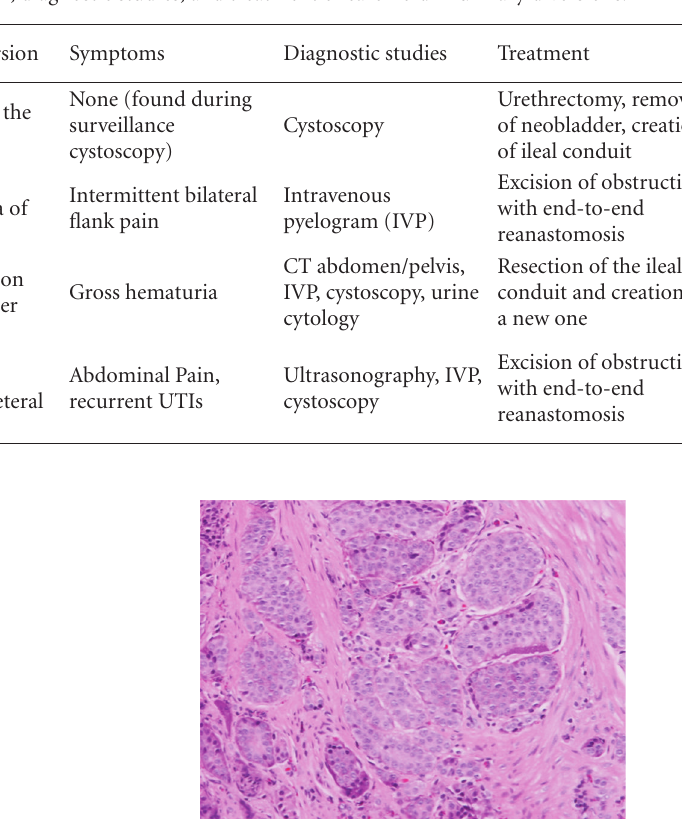
Table 1: Summary showing the initial presentation, diagnostic studies, and treatment of carcinoid in urinary diversions.